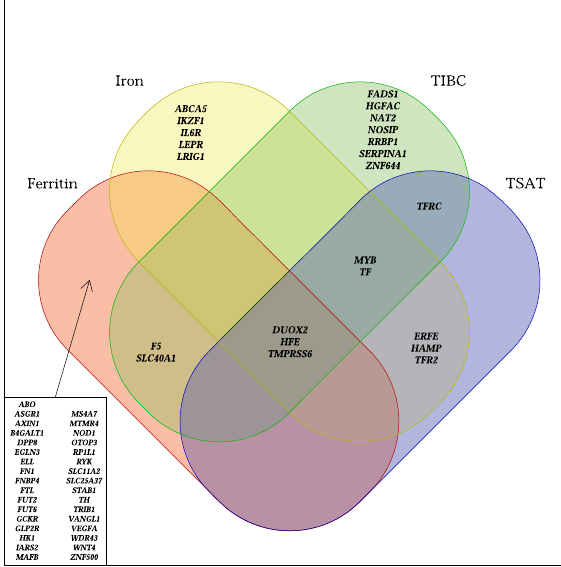
Fig. 3 Venn diagram. Venn diagram showing loci (with predicted gene) harboring variants associated with ferritin, iron, TIBC, and/or